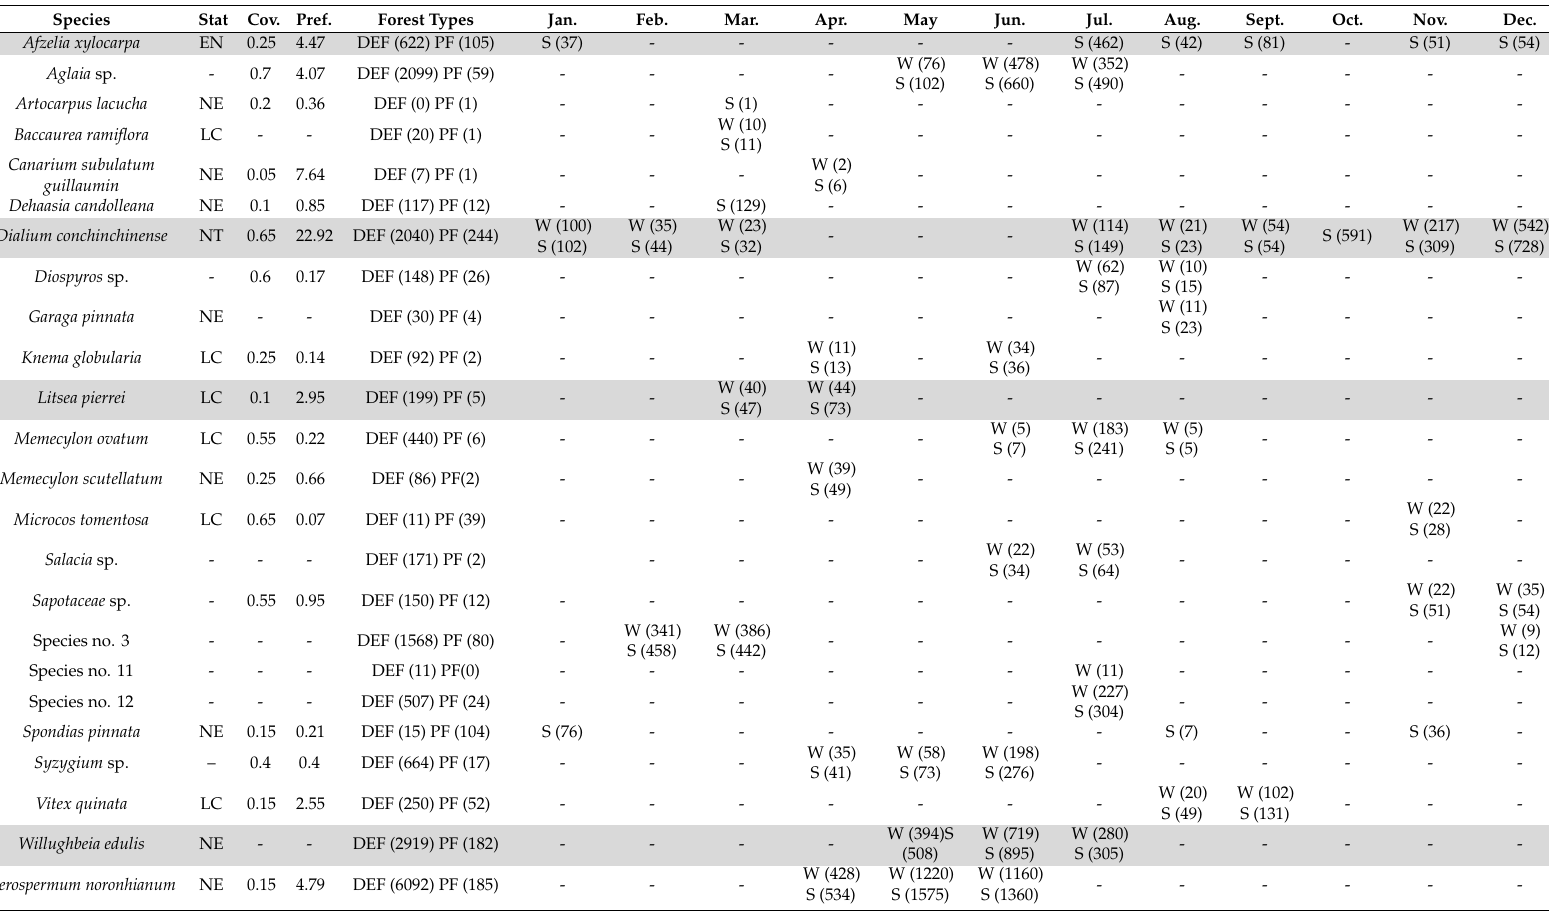
Table A2. Main plant species in northern pigtailed macaques’ important feeding sites in Sakaerat used by MOST over the 12 simulated months, with frequencies of dispersed seeds in Dry-Evergreen Forest (DEF) or Plantation Forests (PF) and their processing methods (swallowed or spat out) according months. Species Stat Cov. Pref. Forest Types